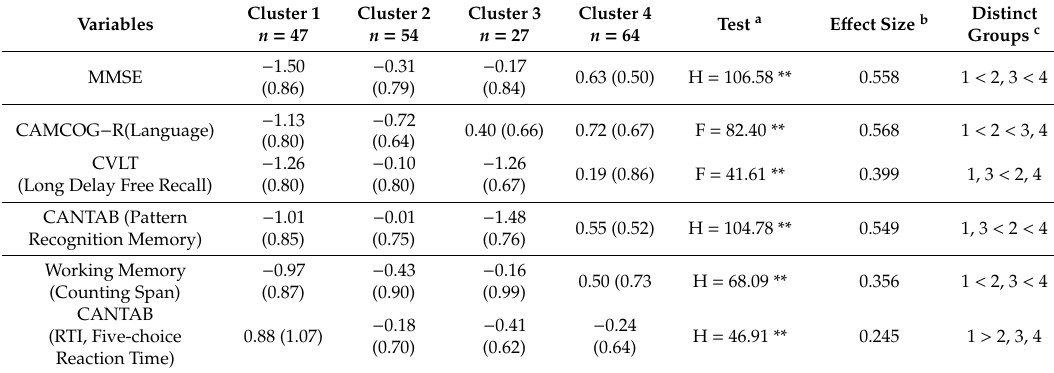
Table 2. Neuropsychological characteristics ( z scores) of variables used for cluster analysis (means and standard deviations in parentheses) and comparisons of the four empirical groups (Cluster 1, Cluster 2, Cluster 3 and Cluster